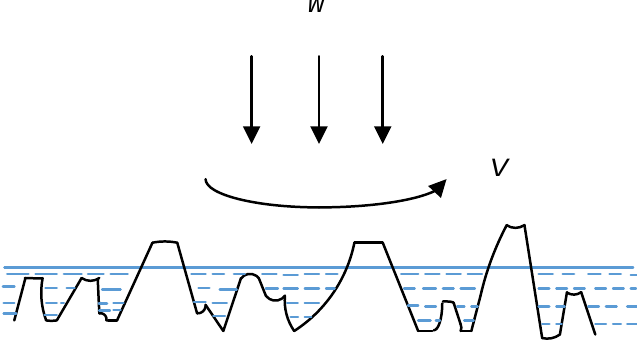
Figure 2. Friction contact mixed-lubrication area.